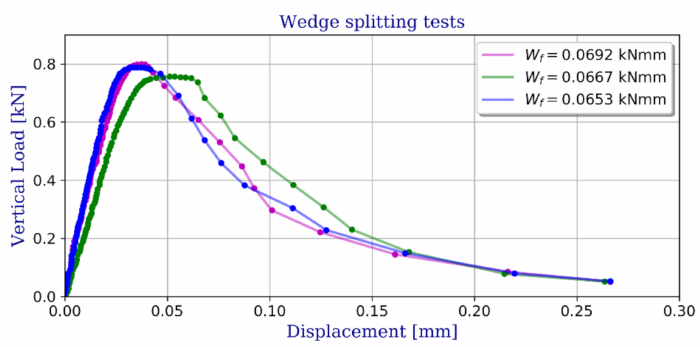
Figure 5. Wedge splitting tests—vertical load vs. crack mouth opened deflection (CMOD).